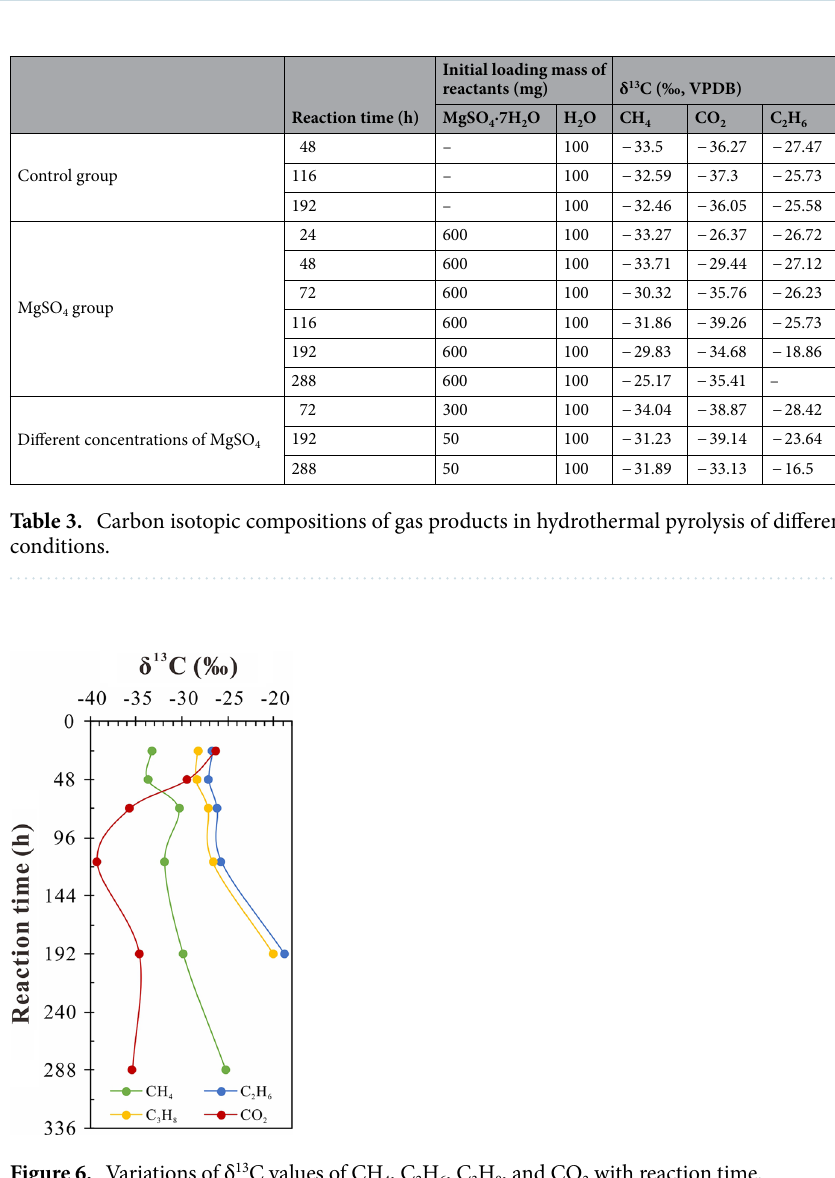
Figure 6. Variations of δ 13 C values of CH 4 , C 2 H 6 , C 3 H 8 , and CO 2 with reaction